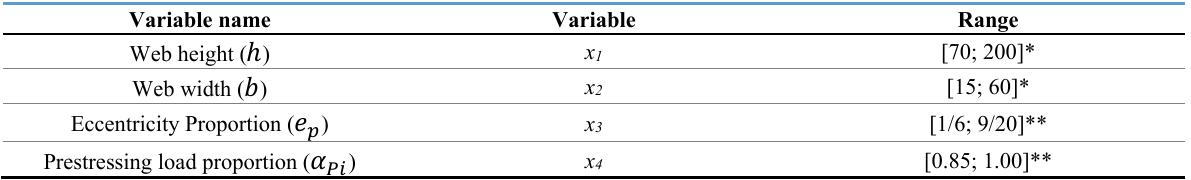
Table 5. Range of design variables of the optimization problem.